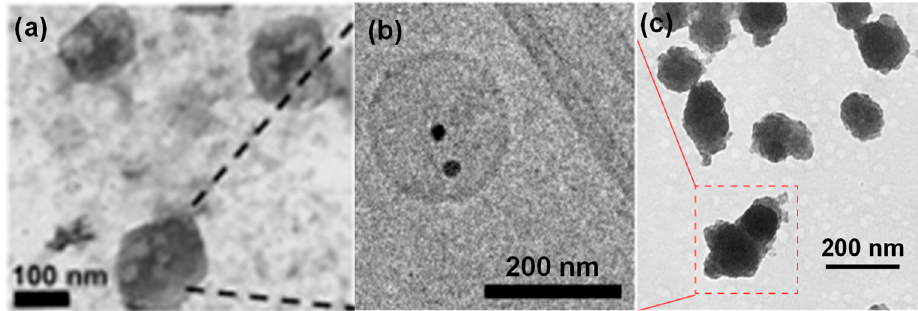
Figure 3. TEM images of some typical examples of inorganic nanoparticle-loaded exosomes: ( a ) iron oxide nanoparticles-loaded exosomes derived from MSCs [35], ( b ) Au nanoparticle-loaded exosomes derived from melanoma B16F10 cells [36], and ( c ) porous silicon nanoparticles-loaded exosomes derived from Bel7402 cells [37].